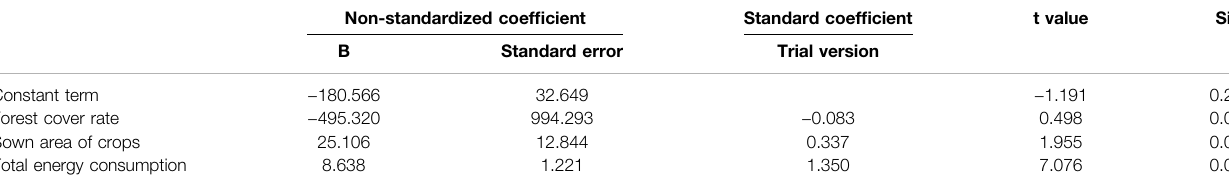
TABLE 2 | The linear regression results of Fujian Province ’ s regional GDP and natural resource